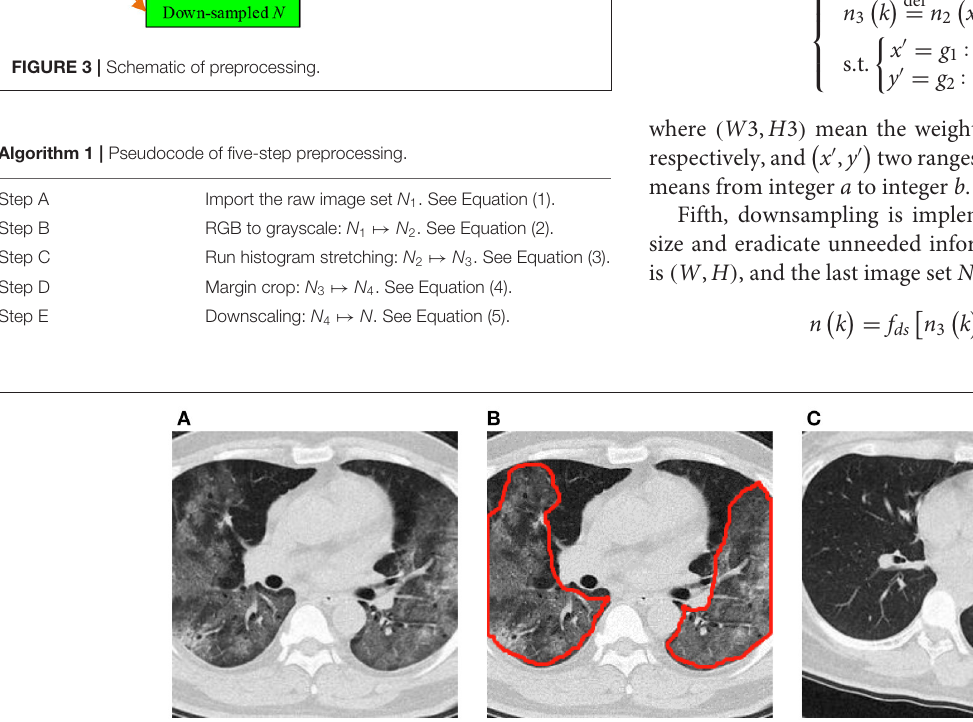
Frontiers in Public Health |